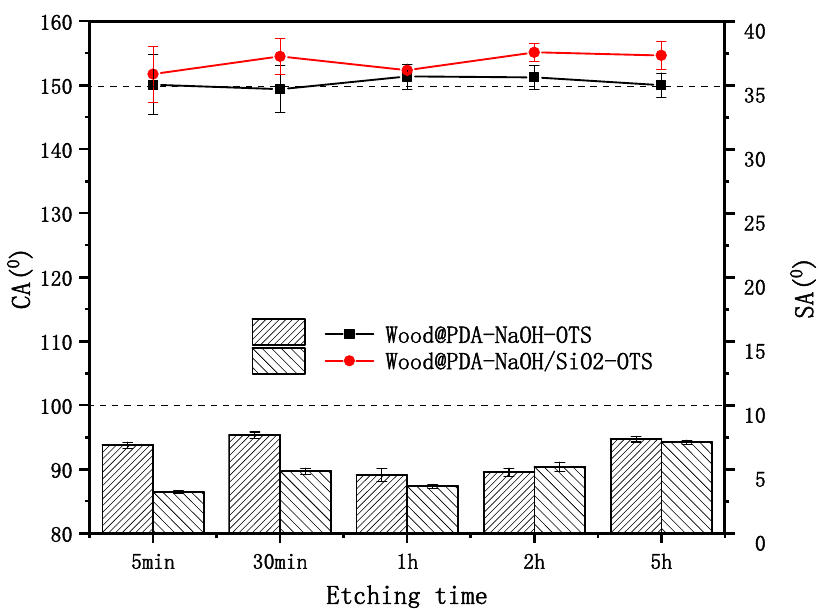
Figure3. Contactangles(CAs)(inlines)andslidingangles(SAs)(inbars)oftheWood@PDA–NaOH–OTS and the Wood@PDA–NaOH / SiO 2 Figure 3. Contact angles (CAs) (in lines) and sliding angles (SAs) (in bars) of the Wood@PDA–NaOH– OTS and the Wood@PDA–NaOH/SiO 2 –OTS.